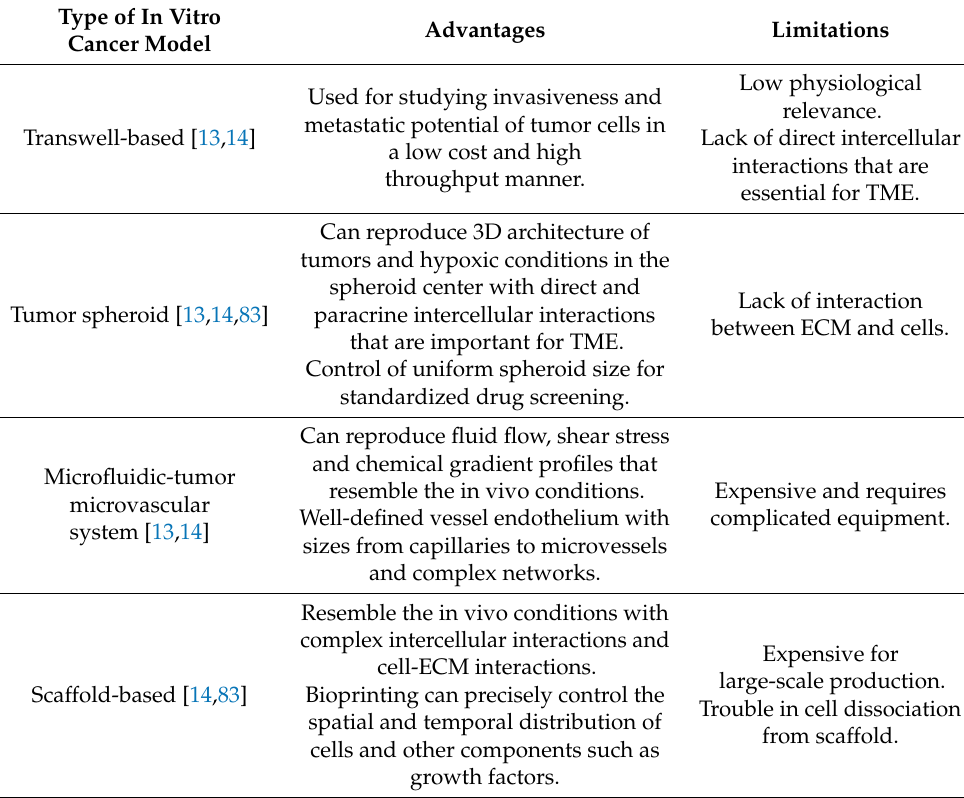
Table 1. Advantages and limitations of the existing types of in vitro cancer